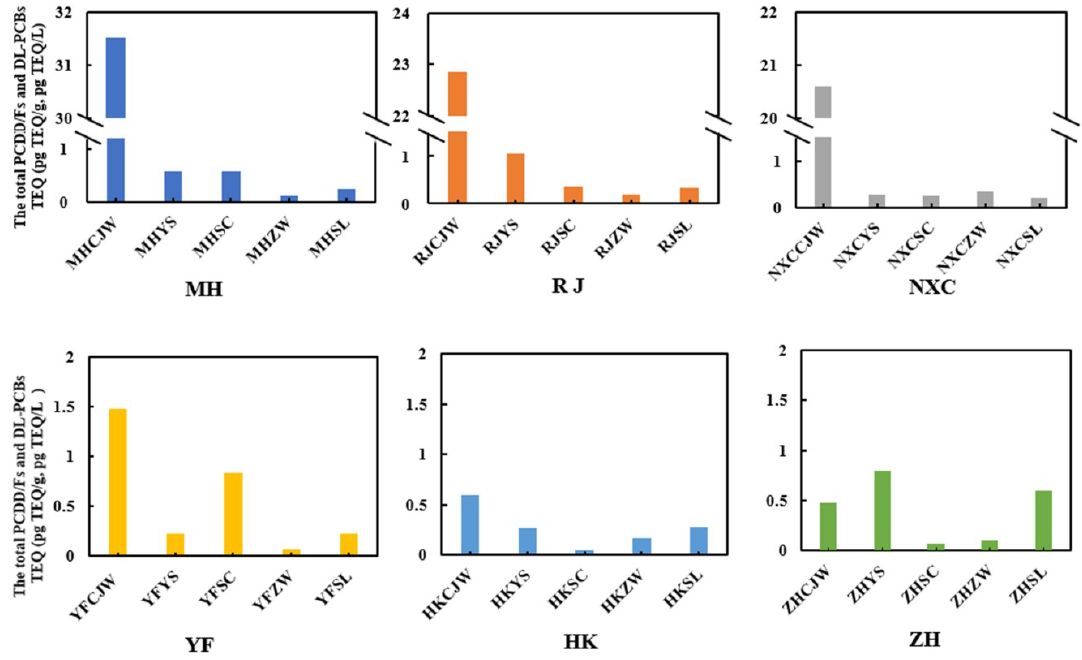
Figure 5. The total PCDD/F and DL-PCB TEQs in the potential sources. The congeners of PCDD/Fs and DL-PCBs in the potential sources and in the crabs were similarly distributed. OCDD and 1,2,3,4,6,7,8-HpCDD were dominant in aquacul- ture water, aquatic plants, and, especially, in sediments. 2,3’,4,4’,5 -PeCB was abundant in sediment, aquaculture water, and feed. Different congeners contribute differently to the TEQ in different samples. For PCDD/Fs, 1,2,3,4,6,7,8-HpCDD had the highest TEQ in sed- iment, aquatic plants, and aquaculture water, with contribution rates of 39%, 32%, and 21%, respectively. In addition, in feed, 1, 2, 3, 7, 8-PeCDD contributed to 40%. For the DL- PCBs, 3,3’,4,4’,5 -PeCB made the most dominant contributions in almost all of the samples, followed by 3,3’,4,4’,5,5’ - HxCB, which is consistent with our conclusion that 3,3’,4,4’,5 - PeCB (90%) and 3,3’,4,4’,5,5’ -HxCB (9%) predominate in crab samples. 3.4. Bioaccumulation of PCDD/Fs and DL-PCBs in Crabs Sediments, aquacultural water, aquatic plants, shore plants, and feed can all enter crabs, so pollutants from each aquacultural process can accumulate in crabs, posing a threat to our health. The above results showed that the DL-PCBs to PCDD/Fs concentra- tion ratio in farm crabs was 191.62%. In sediments, aquacultural water, aquatic plants, shore plants, and feed, the DL-PCB to PCDD/F concentration ratios were 0.20%, 2.72%, 2.22%, 13.36%, and 2553.51%, respectively. In contrast, the concentrations of PCDD/Fs were higher in sediments, aquacultural water, aquatic plants, and shore plants than in crabs, while the concentrations of DL-PCBs were lower in sediments, aquacultural water, aquatic plants, and shore plants than in crabs (Figure S1). These results indicate that crabs bioaccumulate DL-PCBs more readily than PCDD/Fs and that raw materials used in feed may be contaminated with DL-PCBs. To determine the key link responsible for the accumulation of pollutants in crabs, we conducted a correlation analysis of the residual pollutants in crabs and the potential sources, and the correlation coefficient R was used to measure the relationship between the crabs and potential sources. The correlation coefficient between crabs and sediment